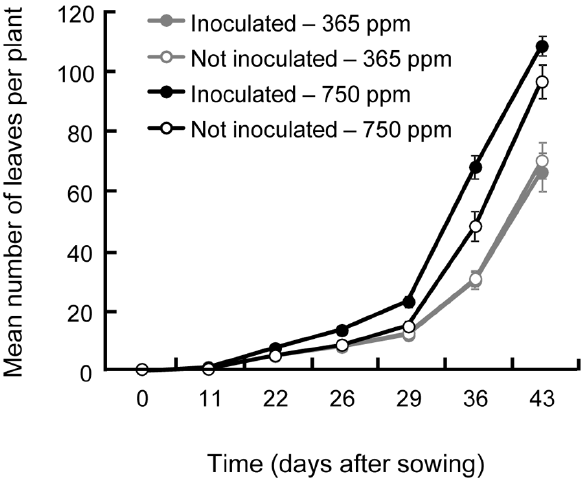
Figure 1. Average number of leaves of Medicagotruncatula over its growth. The number of leaves depends on the CO 2 concentration and the inoculation with Pseudomonas fluorescens C7R12. An ANOVA for repeated measures was made because this trait was measured several times on the same plants. Standard errors are represented by vertical bars. V and Fp corresponds to the plant developmental stages analysed in the experiment.